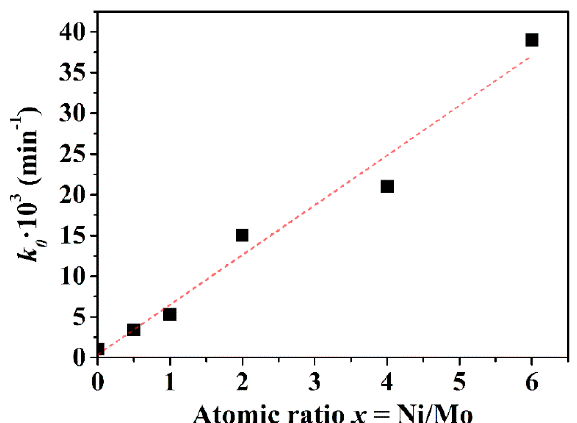
Figure 12. Dependence of the reaction rate constant k 0 for different calcined and reduced catalysts Ni x MoC–SiO 2 (400/600) and calcined sample MoC–SiO 2 (700) on the atomic ratio x = Ni/Mo. Reaction conditions: T = 150 °C, P = 6.0 MPa, m cat = 1.000 g, and furfural/isopropanol molar ratio equal to 0.033.